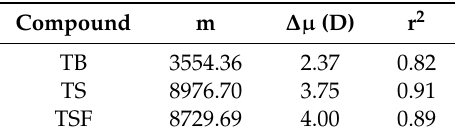
Table 1. Slope m from Stokes shift versus microscopic polarity function, change in dipole moment ∆ µ , and coe ffi cient of determination r 2 for TB , TS , and TSF .